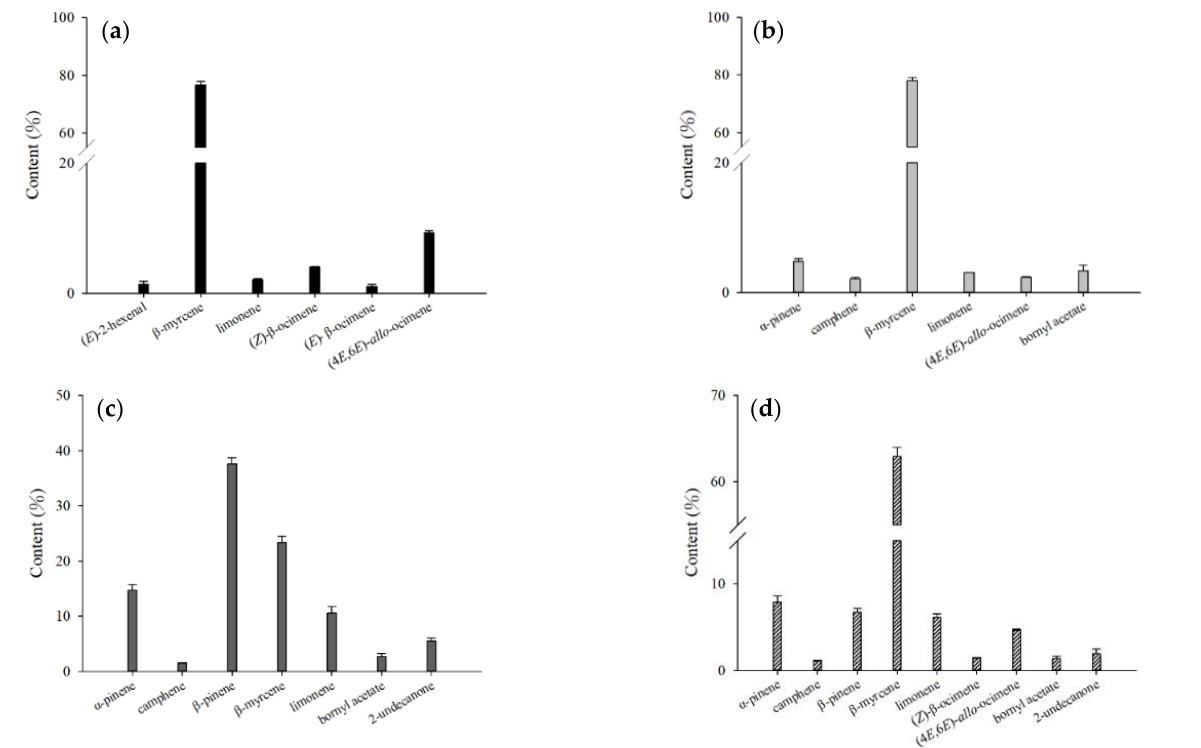
Figure 5. Comparison of the contents of the major volatile compounds in essential oil from different parts of fresh H. cordata analyzed by HS-SPME: ( a ) leaf; ( b ) stem; ( c ) rhizome; and ( d ) whole plant.